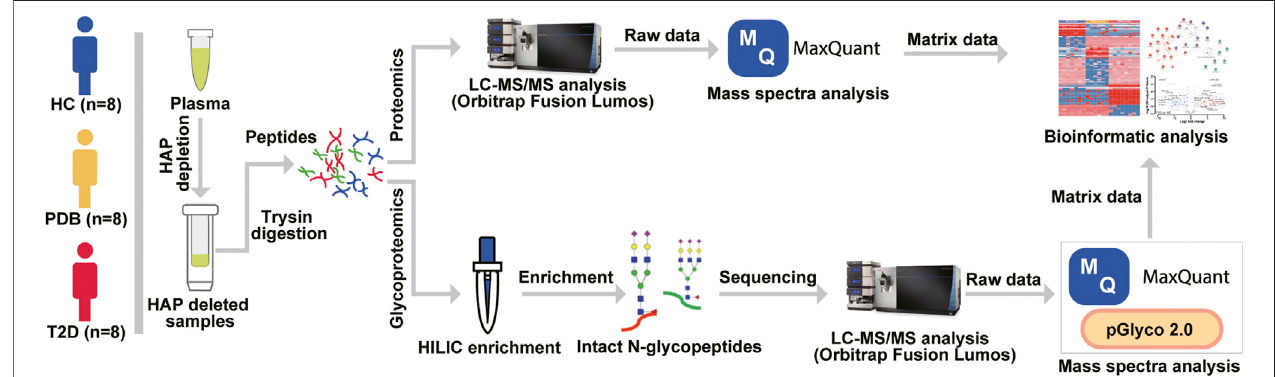
FIGURE 1 | Mass spectrometry – based proteomic and glycoproteomic work fl ow. The 12 highest abundance proteins (HAPs) in the plasma were removed by Pierce ™ TOP 12 Abundant Protein Depletion Spin Columns according to the user manual, and then the HAP depleted samples were digested by a modi fi ed FASP protocol. For proteomic analysis, the digested peptides were directly analyzed by an Orbitrap Fusion Lumos LC-MS/MS instrument, and mass spectra were searched against the human UniProt database using MaxQuant software before bioinformatic analysis. For glycoproteomic analysis, a Hilic enrichment analysis was conducted for digested peptides, and then the enriched N-glycopeptides were analyzed by LC-MS/MS instrument. The raw data were processed by MaxQuant and pGlyco software before bioinformatic analysis.